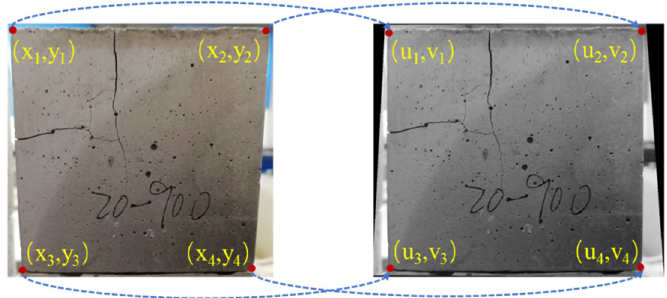
Figure 1. Tilt correction of specimen.